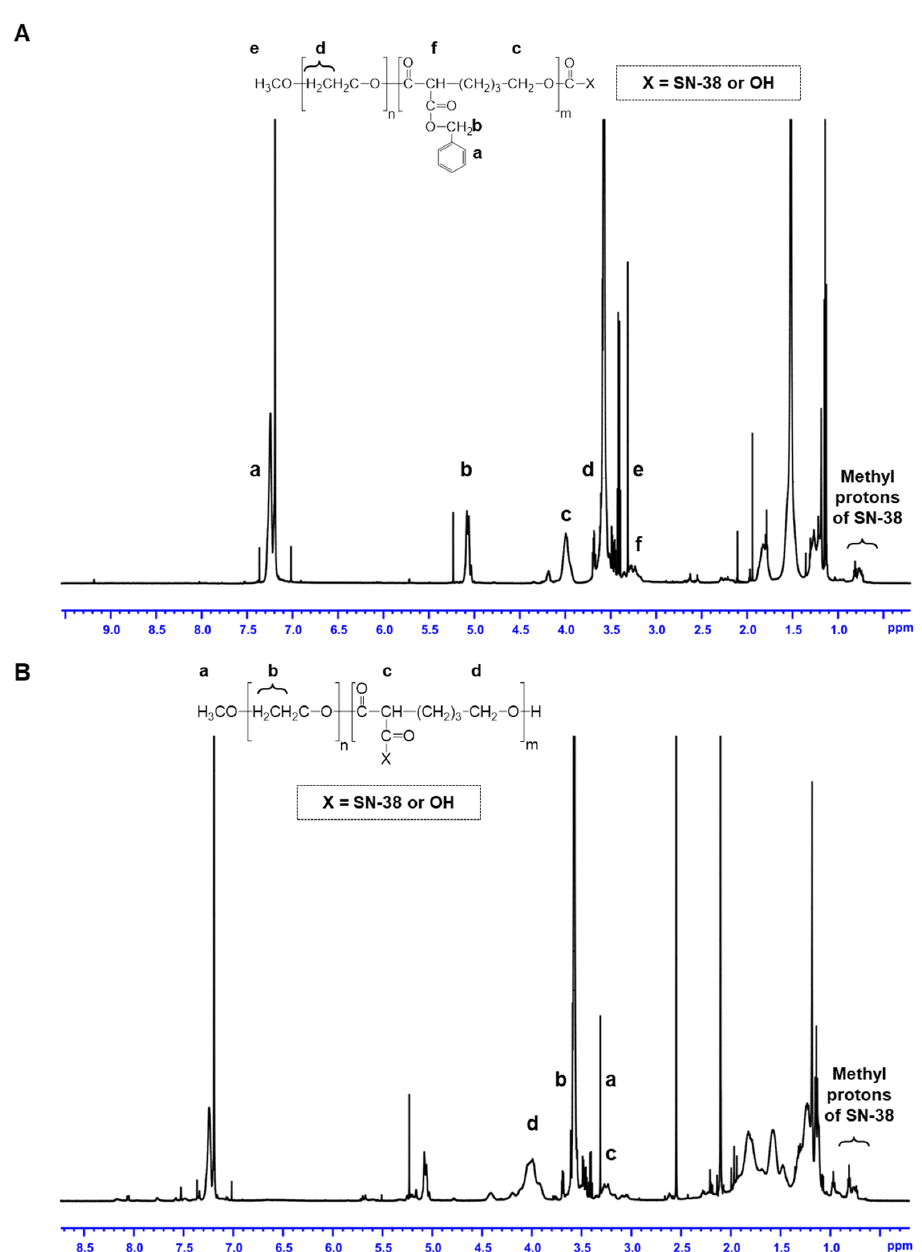
Figure 2. 1 H NMR spectra and corresponding peak assignments for ( A ) mPEO- b -PBCL/SN-38 and ( B ) mPEO- b -PCCL/SN-38.